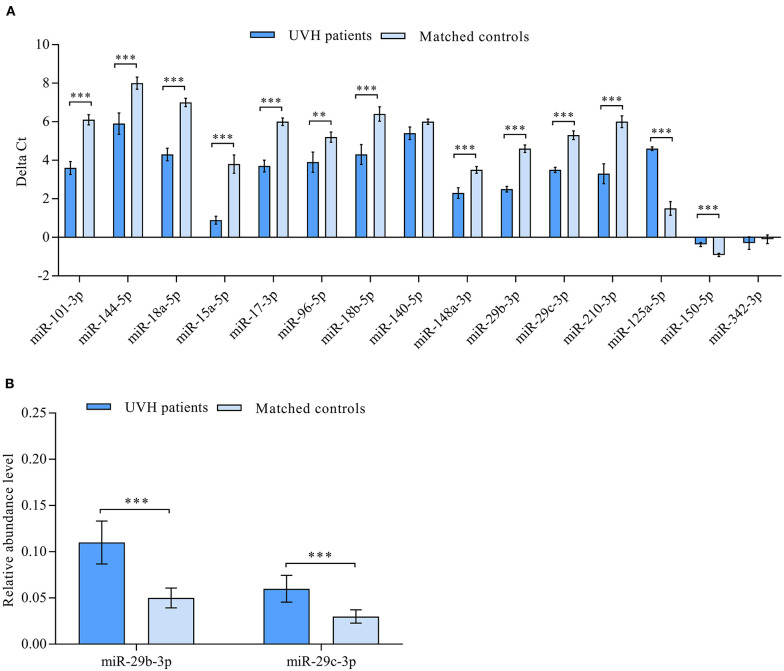
(A) Validation of differentially abundant miRNAs in the blood of patients with univentricular heart (UVH) (n = 48) compared to age and gender-matched healthy controls (n = 32) as determined by RT-qPCR (P < 0.05). Mean ΔCt values of patients and healthy controls (lower ΔCt values indicating higher abundance levels). (B) Validation of clinically correlated differentially abundant miR-29b-3p and miR-29c-3p in the blood of UVH patients (n = 48) compared to age and gender-matched healthy controls (n = 32) as determined by RT-qPCR (P < 0.05). Mean relative abundance level (2−ΔCt) of patients and healthy controls are shown with RNAU6B as an endogenous control for normalization. Un-paired-two-tailed t-tests and mean ± standard deviation (STDV) were used to evaluate differences in abundance levels. **P ≤ 0.01; ***P ≤ 0.001.